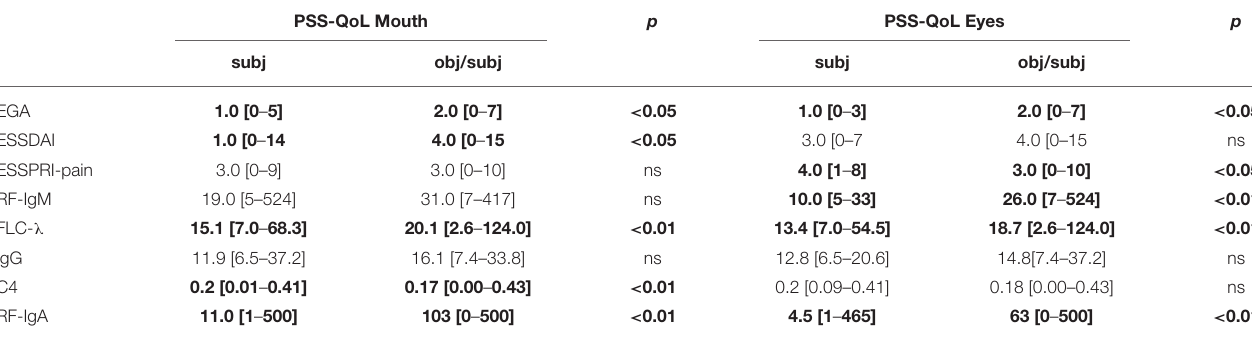
TABLE 4 | Comparison of perceived dryness-groups with clinical